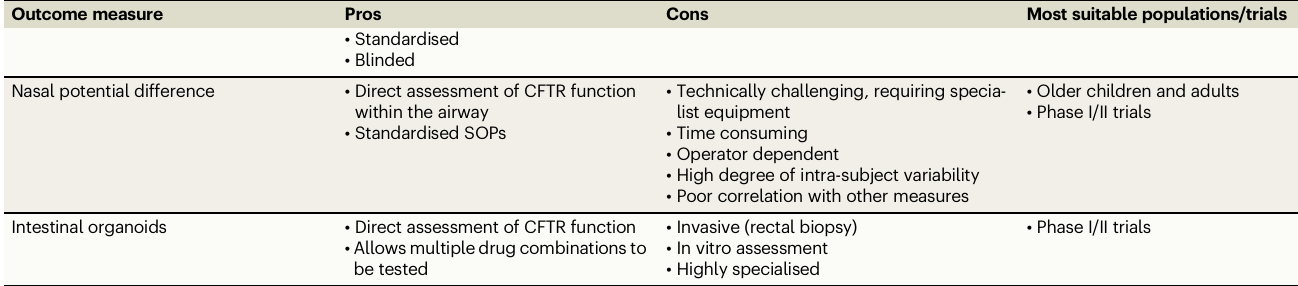
Table 1 (continued) | Pros, cons and optimal use of current and future CF trial outcome